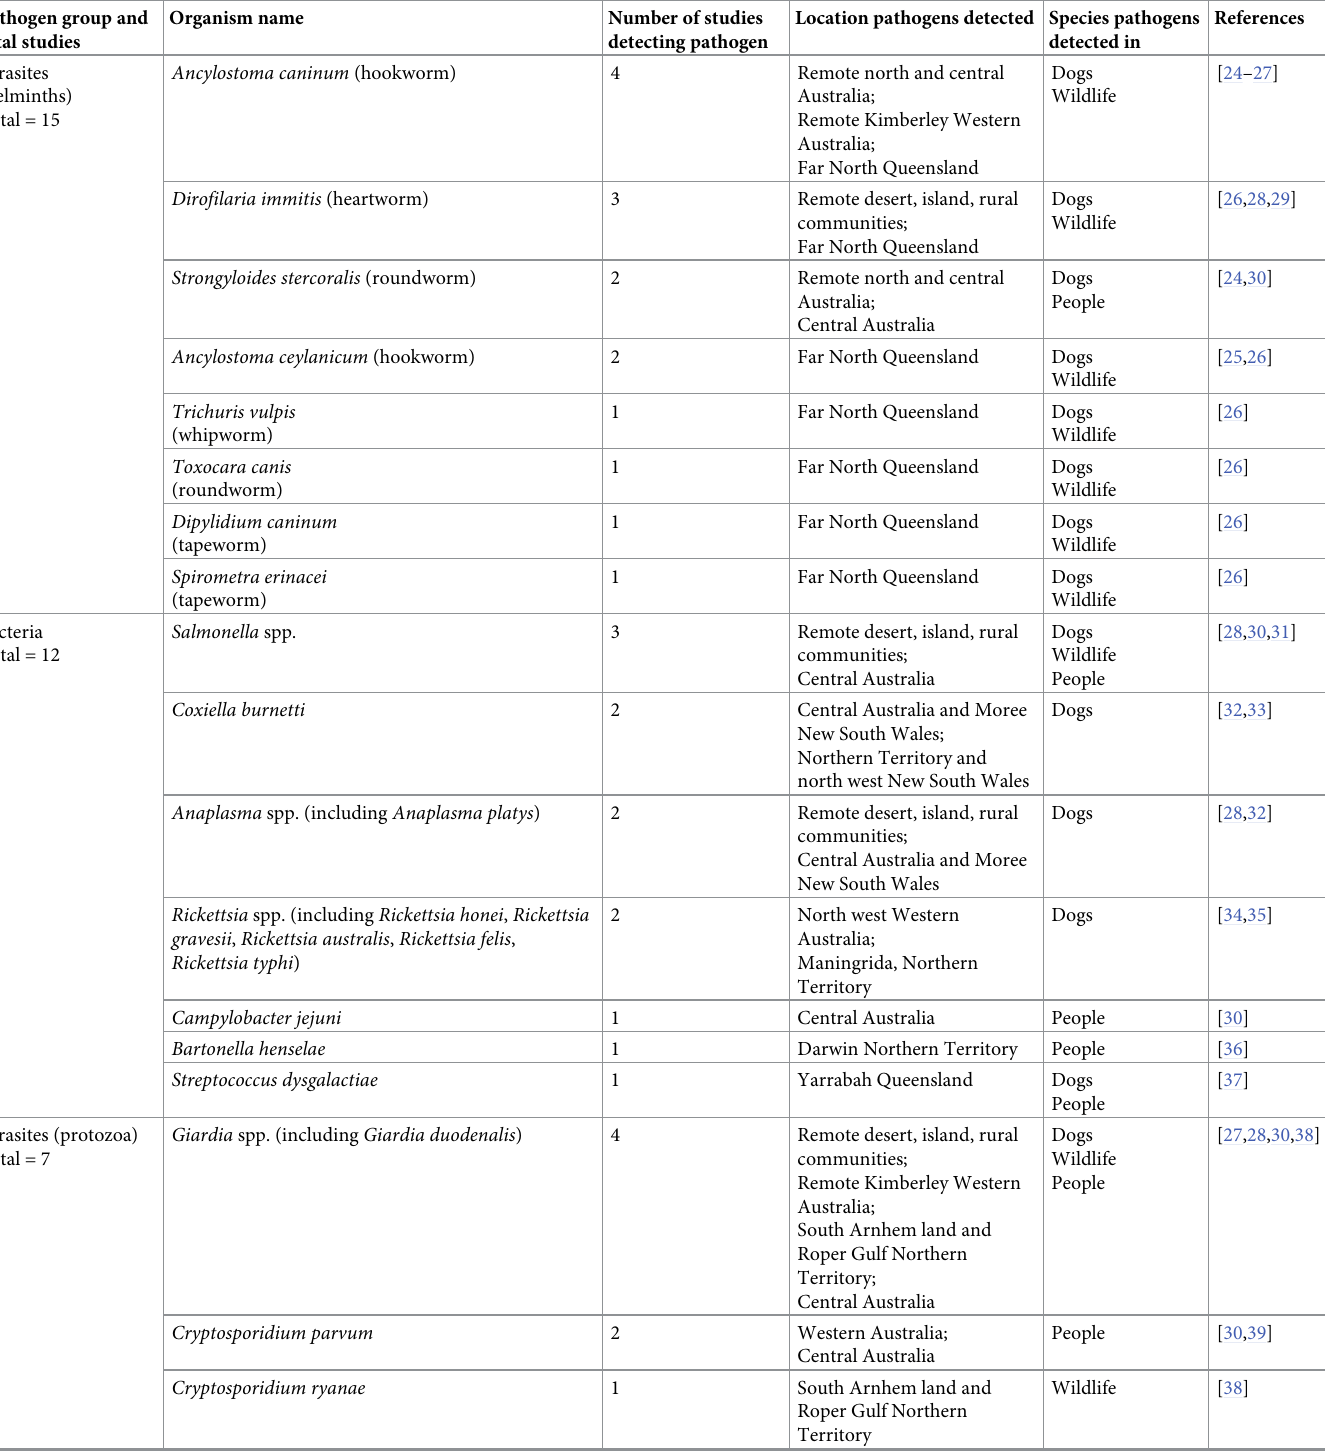
Table 2. Summary of zoonotic pathogens in the evidence